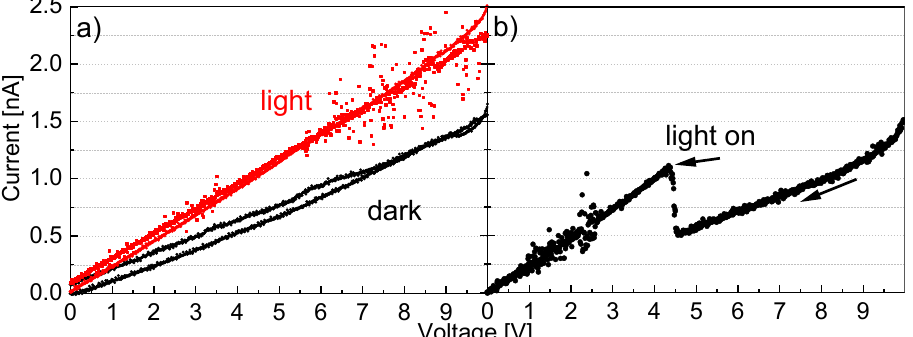
Figure 8. ( a ) TLM response of a sample in dark (black lines) and illuminated (red lines) for a contact distance of 800 µm. ( b ) The sample was illuminated while sweeping.